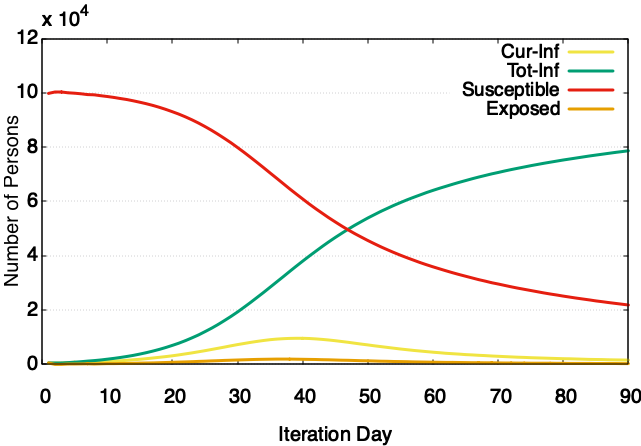
Figure 7. Modeling of SIS using SIM-D. The number of people in different states vary as the simulation progresses through